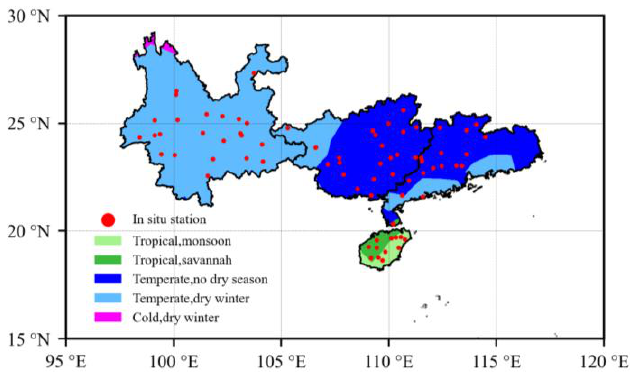
Figure 1. Climate zones according to the Köppen–Geiger climate classification in the study area and the distribution of in situ stations.